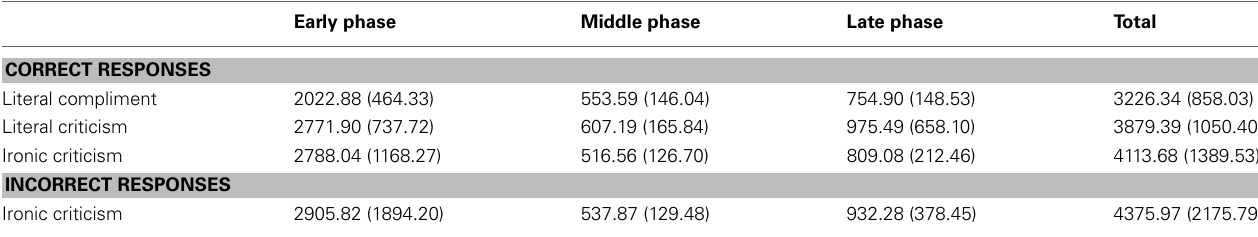
Table 2 | Mean response latencies (ms) for each phase of arm reach during speaker intent actions.